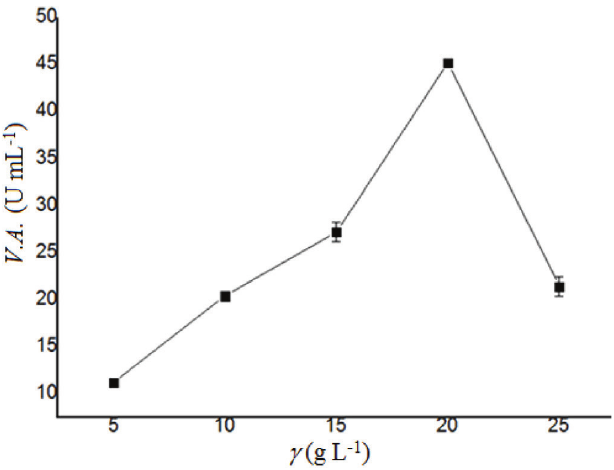
Fig. 2 – Effect of alginate concentration on enzyme activity (with pH 5, temperature 35 °C, rotation rate 120 rpm, and fermentation time 72